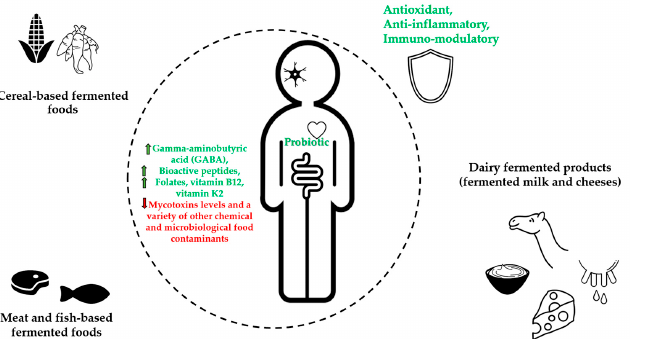
Figure 1. Graphical illustration of the main health effects from African traditional fermented foods .